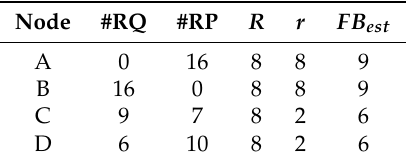
Table 3. Repeal-flooding boundary estimation from node A seeking a route to node B.